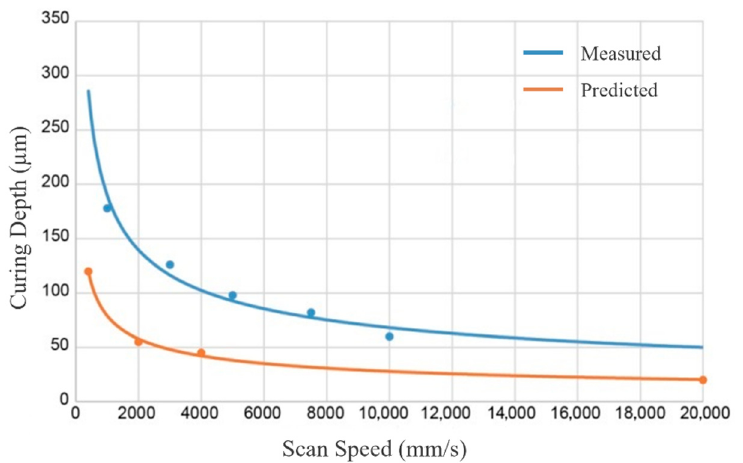
Figure 8. Measured and predicted values for curing depth and corresponding required scan speed for Al 2 O 3 stereolithography.